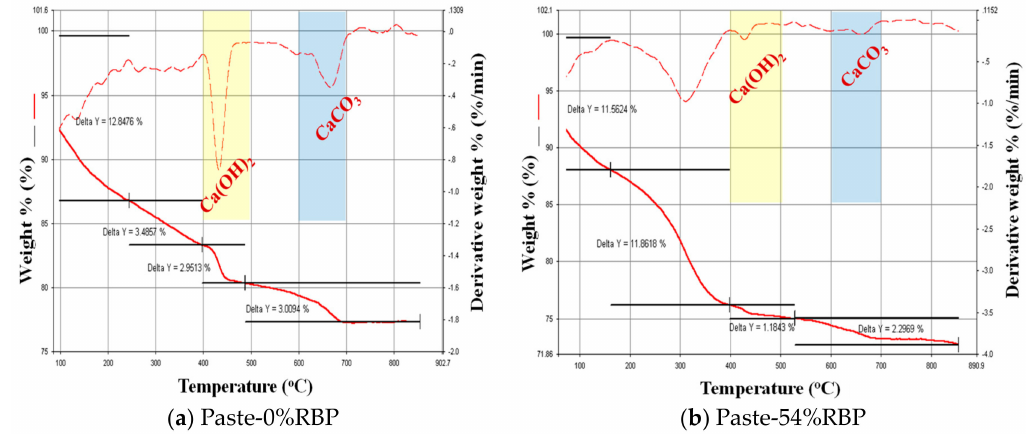
Figure 6. Hydration product analysis for the paste with RBP by DTG test. ( a ) Paste-0%RBP; ( b )